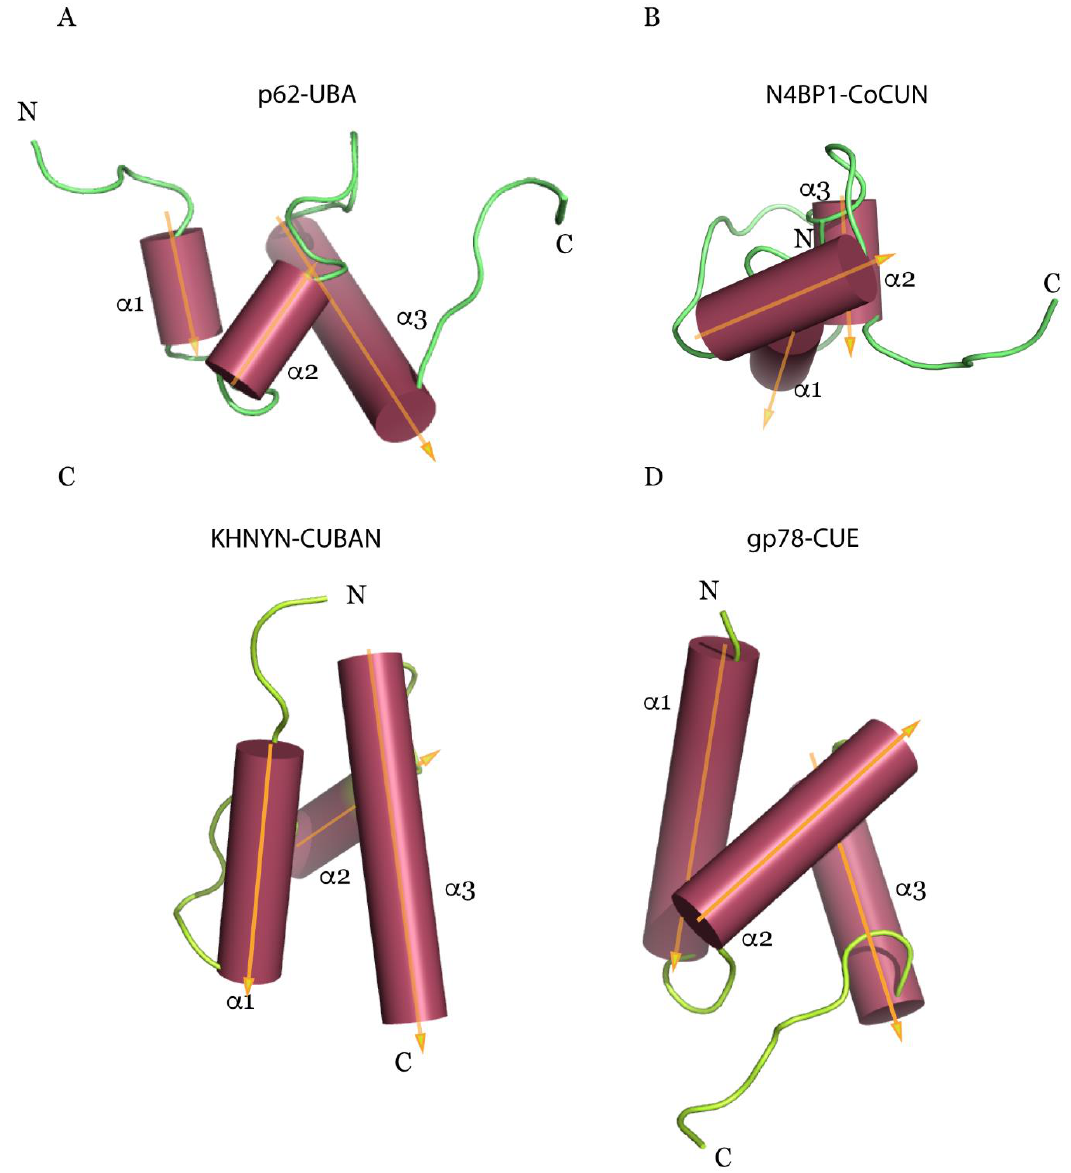
Figure 2. Ribbon representation of Ubiquitin-Associated (UBA) (p62, A ), CUllin-Binding domain Associating with NEDD8 (CUBAN) (KH and NYN domain-containing (KHNYN), ( B ), Cousin of CUBAN (CoCUN) (NEDD4-binding protein-1 (N4BP1), ( C ) and Coupling Ubiquitin conjugation to ER degradation (CUE) (gp78, ( D ) domains. Arrows indicate the relative spatial distributions of the three helices ( α 1, α 2 and α 3). The central helix, located in front of the plane formed by helices 1 and 3 in CUE, UBA and CoCUN domains, is projected on the opposite side in CUBAN.